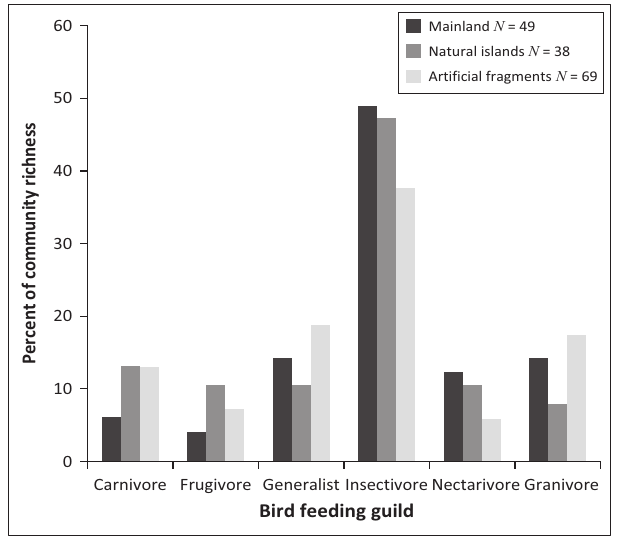
FIGURE 3: The response of three bird feeding guilds to postfire age in the mainland plots shown with percentage of community richness